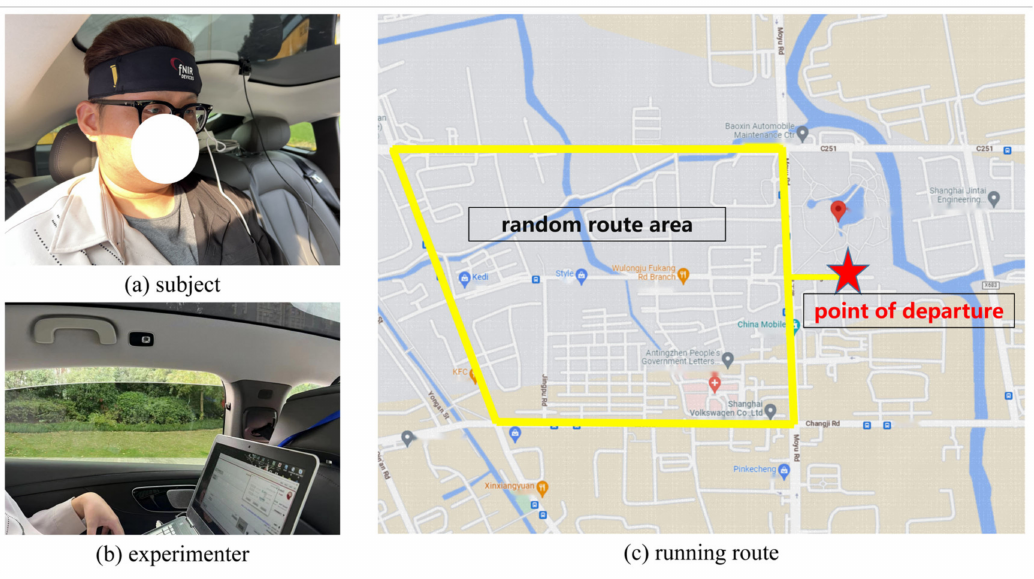
Figure 7. Vehicle test and random route area. ( a ) subject; ( b ) experimenter; ( c ) running route.